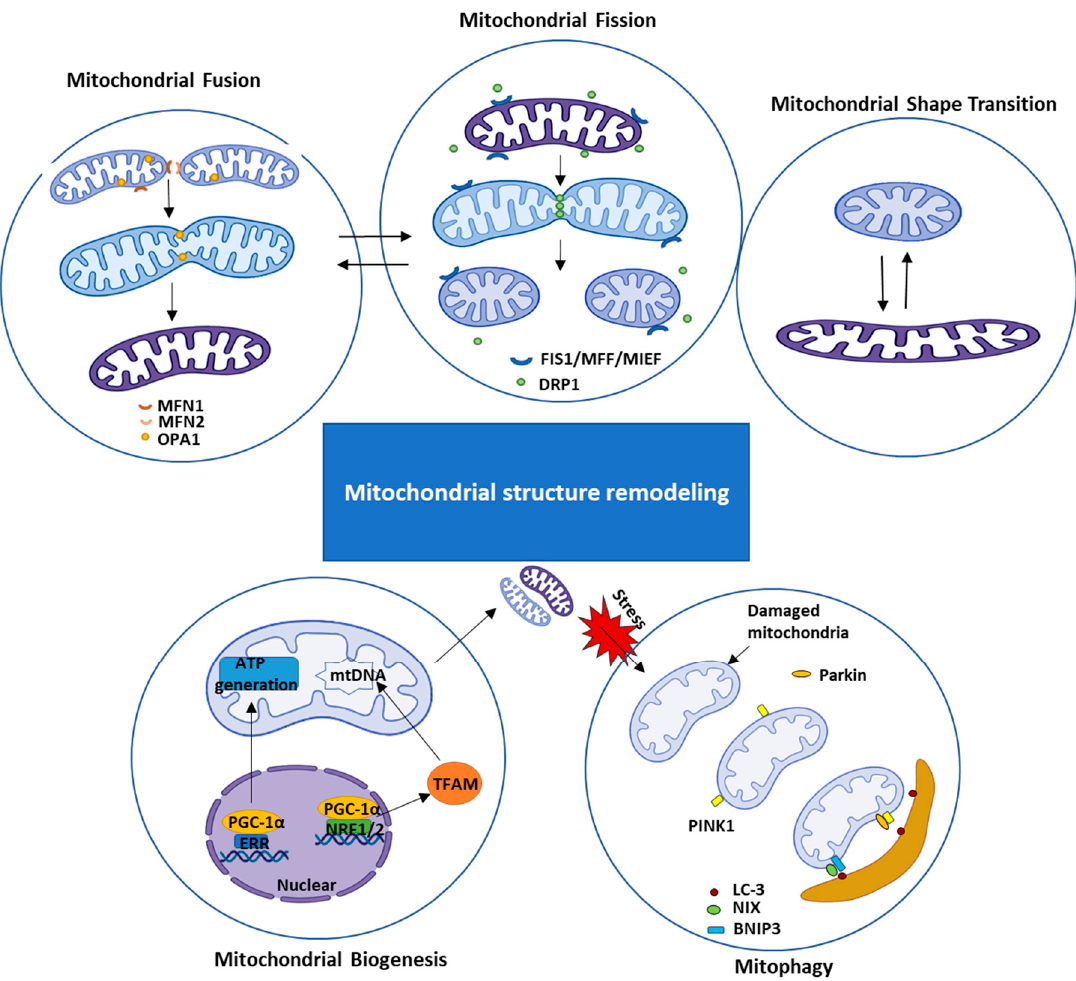
Figure 1. The Illustration of cardiac mitochondrial structure remodeling and mitochondrial dynamics. The mitochondria exhibit an adaption through changing mitochondrial morphology and numbers by fusion, fission, mitochondrial shape transition, and coordinated with mitochondrial biogenesis and mitophagy. Each process is mediated by several factors and also regulated by the interactions with other mitochondrial morphology changes. MFN1/2: mitofusin-1/2. OPA1: optic atrophy protein-1. Fis1: fission protein 1. MFF: mitochondrial fission factor. MIEF: mitochondrial elongation factors. DRP1: dynamin-related protein 1. LC-3: Microtubule-associated protein 1A/1B-light chain 3. NIX: NIP3-like protein X. BNIP3: Bcl-2 interacting protein 3. PGC1- α : peroxisome proliferator-activated receptor γ (PPAR γ ) coactivator 1 α . ERR: estrogen-related receptor. NRFs: nuclear respiratory factors. TFAM: mitochondrial transcription factor A. PINK1: PTEN-induced kinase